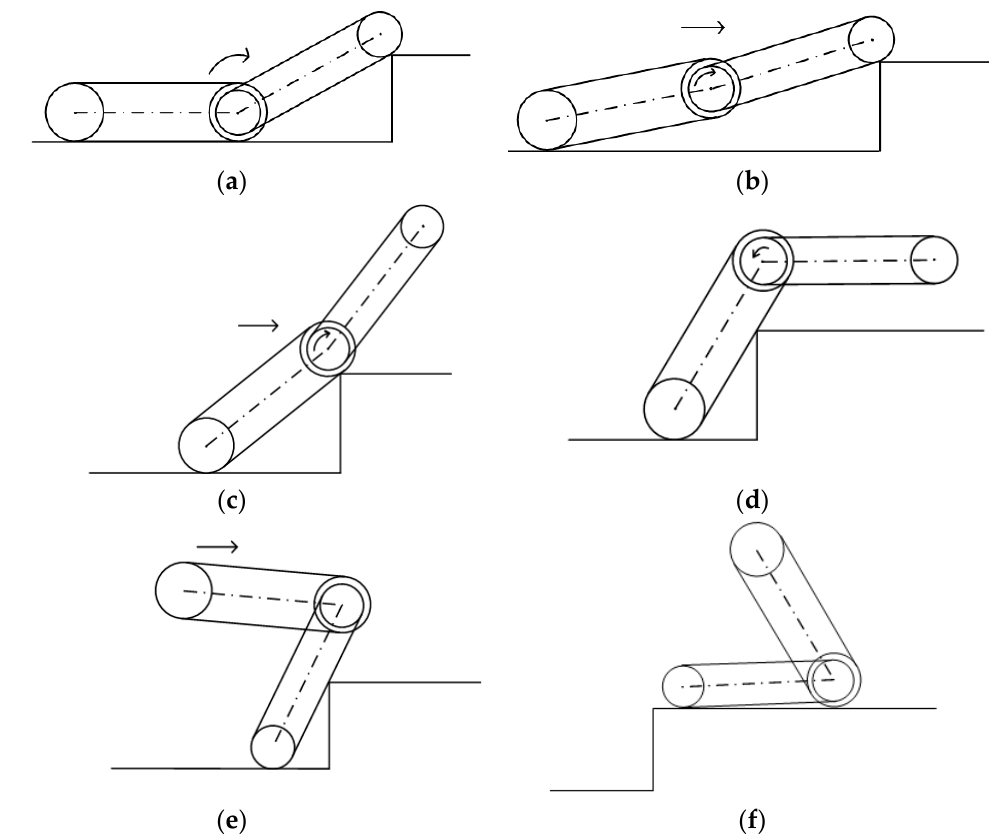
Figure 4. Reverse climbing process of the robot: ( a ) lift the rocker arm; ( b ) lift the body with the support of the rocker arm; ( c ) off-road wheel withstands step angle; ( d ) car body crawler withstands step edges; ( e ) the center of mass crosses the step boundary; ( f ) the body crosses the step.